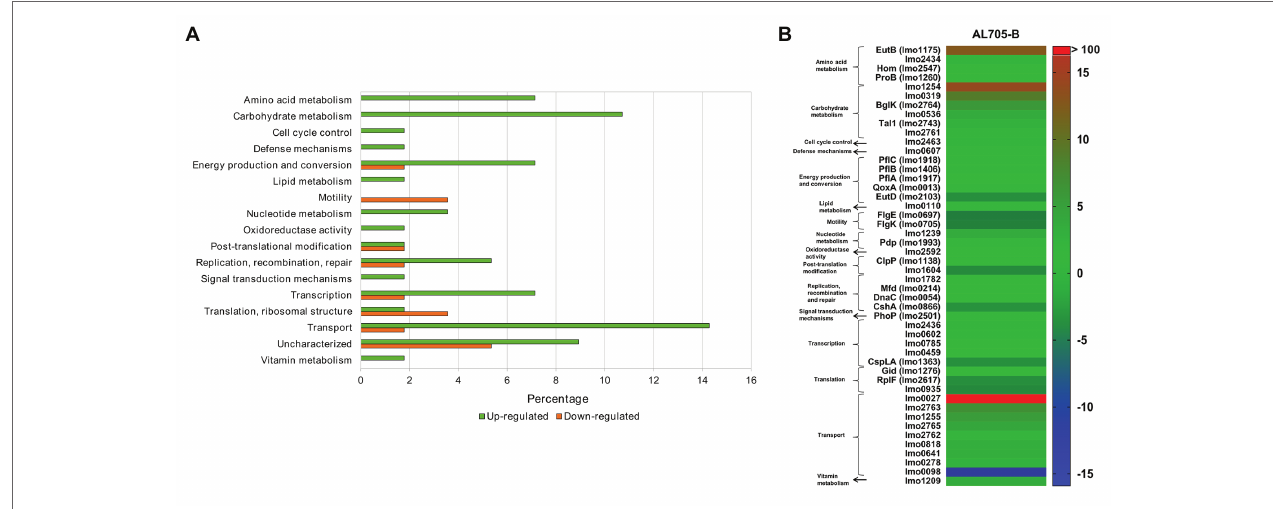
FIGURE 3 | Regulated proteins by L. monocytogenes FBUNT sessile cells treated with bacteriocin AL705 compared to untreated biofilm cells: Horizontal bar chart showing the functional categories and percentages of over and downexpressed proteins (A) and Heat-map illustrating the fold change of the differentially expressed proteins in treated biofilm (B)